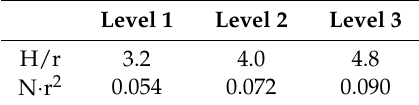
Table 1. Levels of the factorial